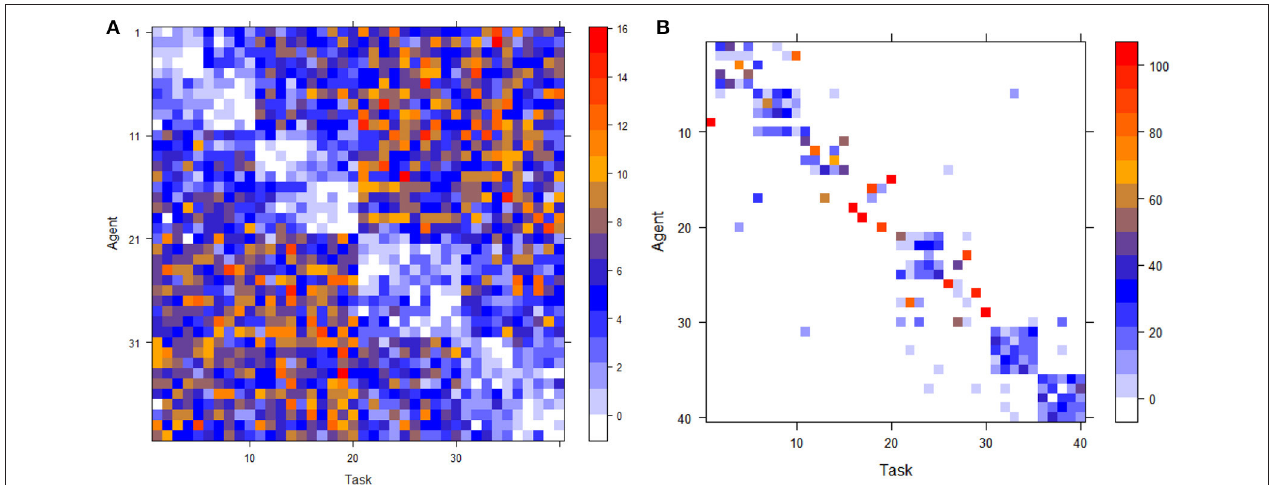
FIGURE 1 | Cost matrix (A) and Overall view of the ensemble of 100 optimal assignment solutions